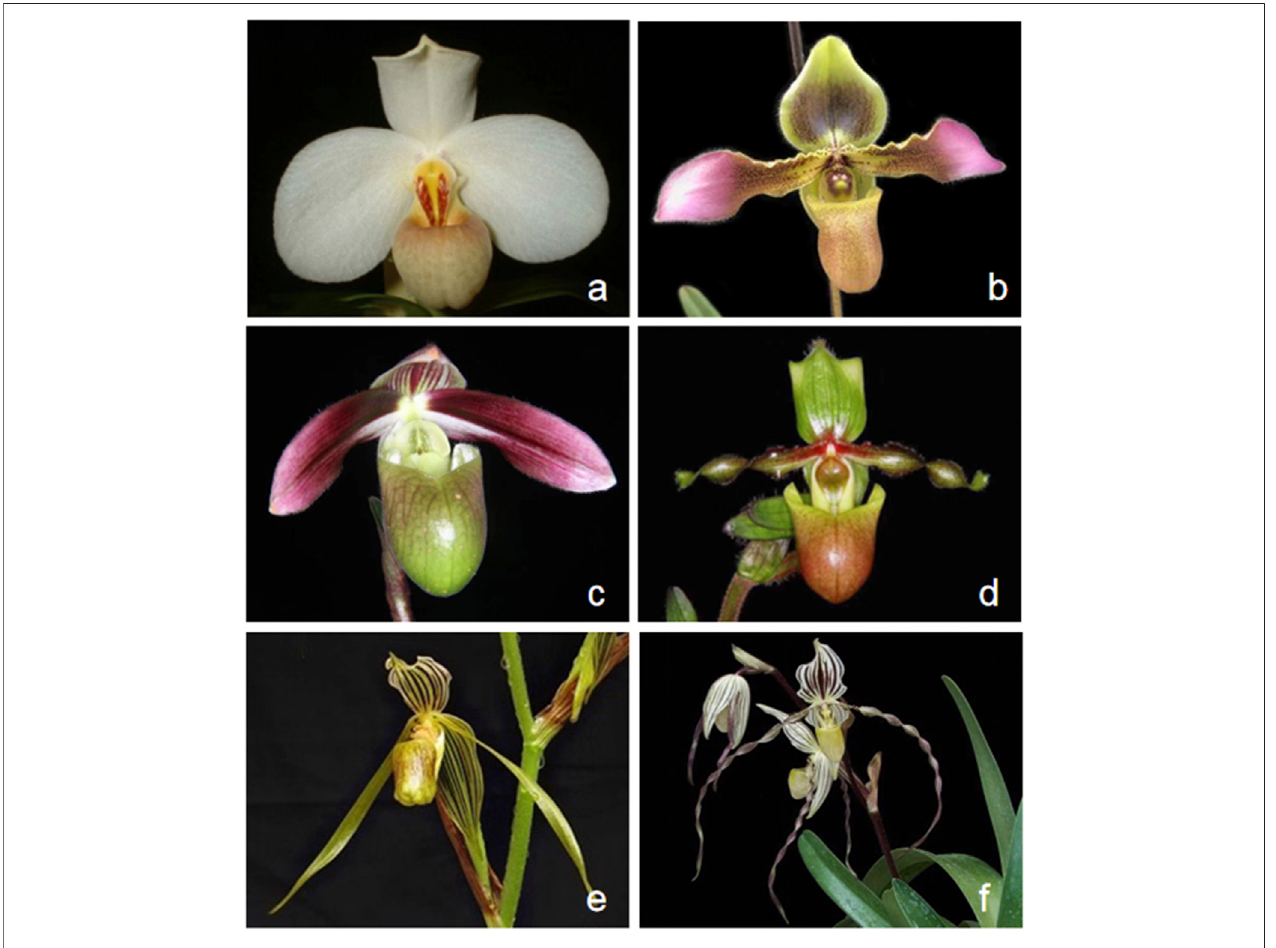
FIGURE 1 | Flower morphological characteristics of six Paphiopedilum species. (A) Paphiopedilum tranlienianum ; (B) Paphiopedilum hirsutissimum ; (C) Paphiopedilum violascens ; (D) Paphiopedilum victoria-mariae ; (E) Paphiopedilum kolopakingii ; (F) Paphiopedilum philippinense .